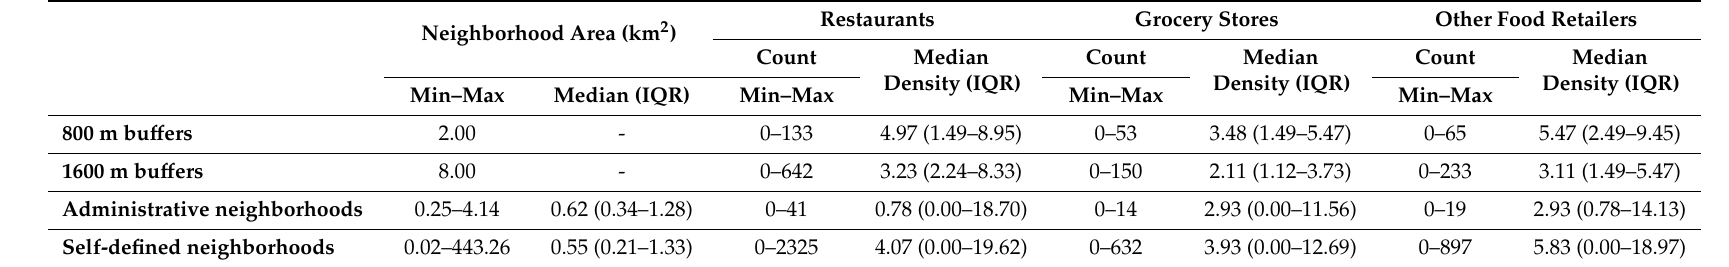
Table 3. Di ff erences in counts and densities of food retailers across neighborhood